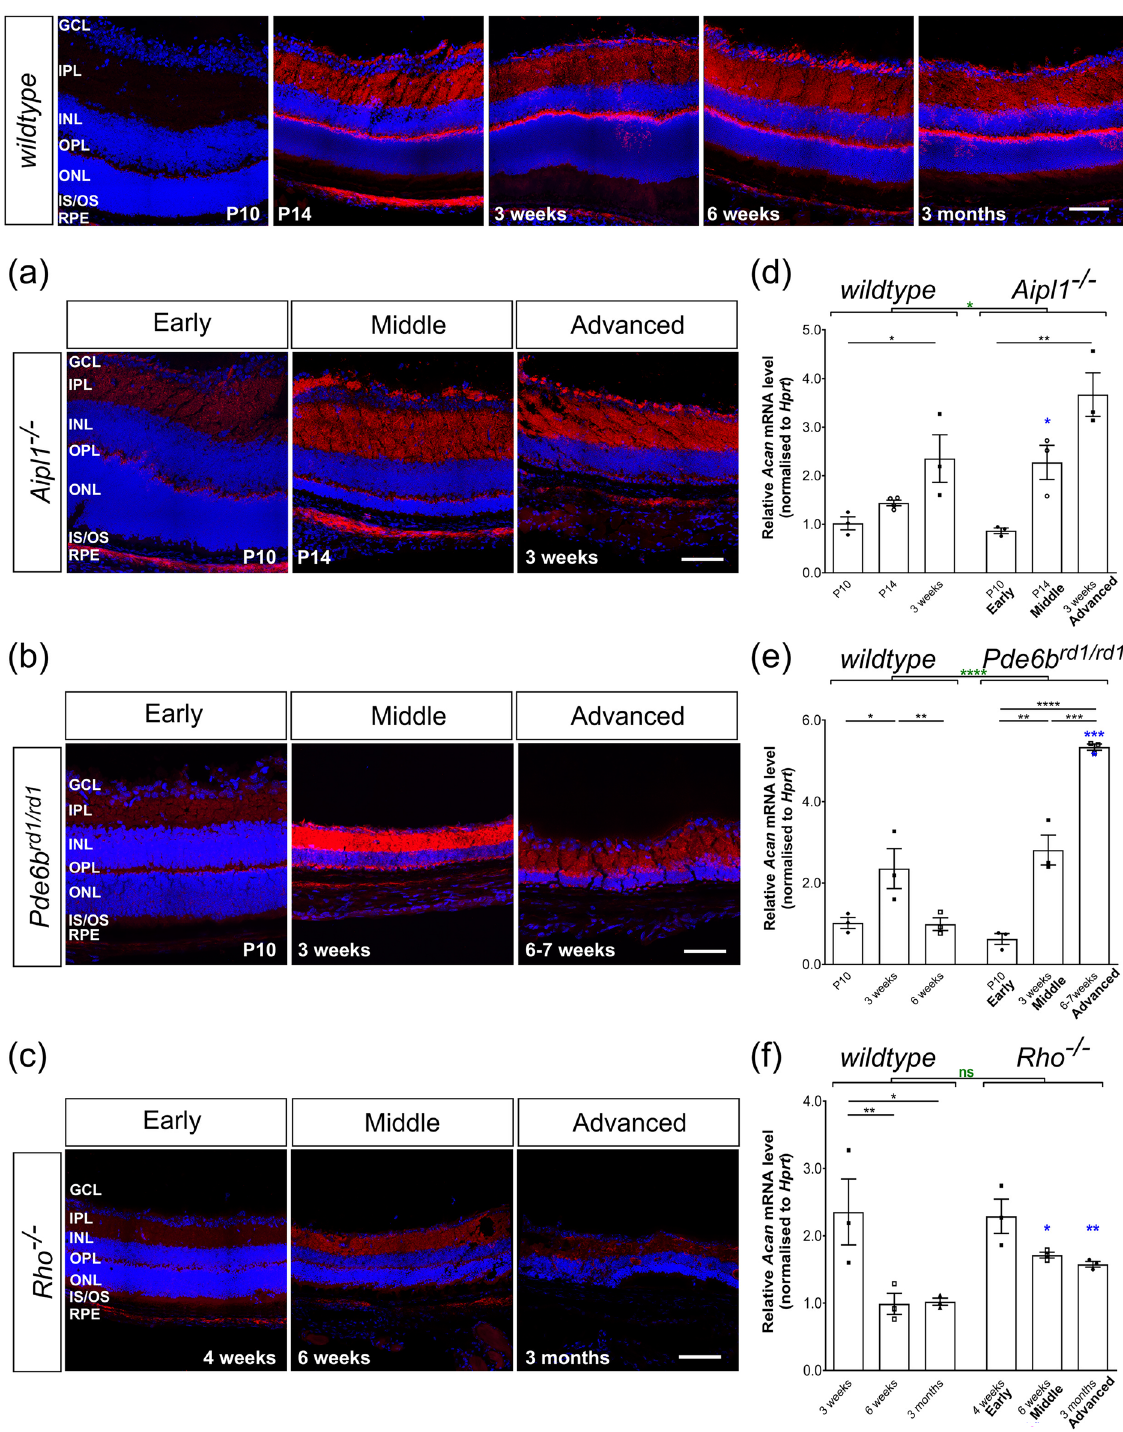
Figure 2. Aggrecan expression is increased in the Aipl1 -/- and Pde6b rd1/rd1 but not Rho -/- models of retinal degeneration. ( a )–( c ), Immunostaining for Aggrecan ( red ) was mainly seen in the OPL, IPL, and GCL with relatively little staining in ONL in all models. Increasing expression was most notable in the IPL, compared to early time- points, in wildtype , Aipl1 -/- and Pde6b rd1/rd1 retinae. ( d )–( f ), Acan mRNA levels were dramatically elevated with disease progression, showing increased expression in ( d ) P14 (mid-stage) Aipl1 -/- and ( e ) 6 week (advanced-stage) Pde6b rd1/rd1 retinae compared to age-matched wildtype mice. ( f ) Acan mRNA levels decreased in adulthood in Rho -/- retinae but remained higher than age-matched wildtype retinae. N.B. mRNA levels shown for wildtype are the same as in Fig. 1b. Scale bar, 100 µm. * p < 0.05, ** p < 0.01, *** p < 0.001, **** p < 0.0001 (one-way ANOVA test with Bonferroni’s correction, black ; unpaired t-test for age-matched comparisons between wildtype and disease model, blue ; two-way ANOVA test applied for assessments of change over time, red ). ONL—outer nuclear layer; OPL—outer plexiform layer; INL— inner nuclear layer; IPL—inner plexiform layer; GCL—ganglion cell layer. Nuclei are counter stained with Dapi ( blue